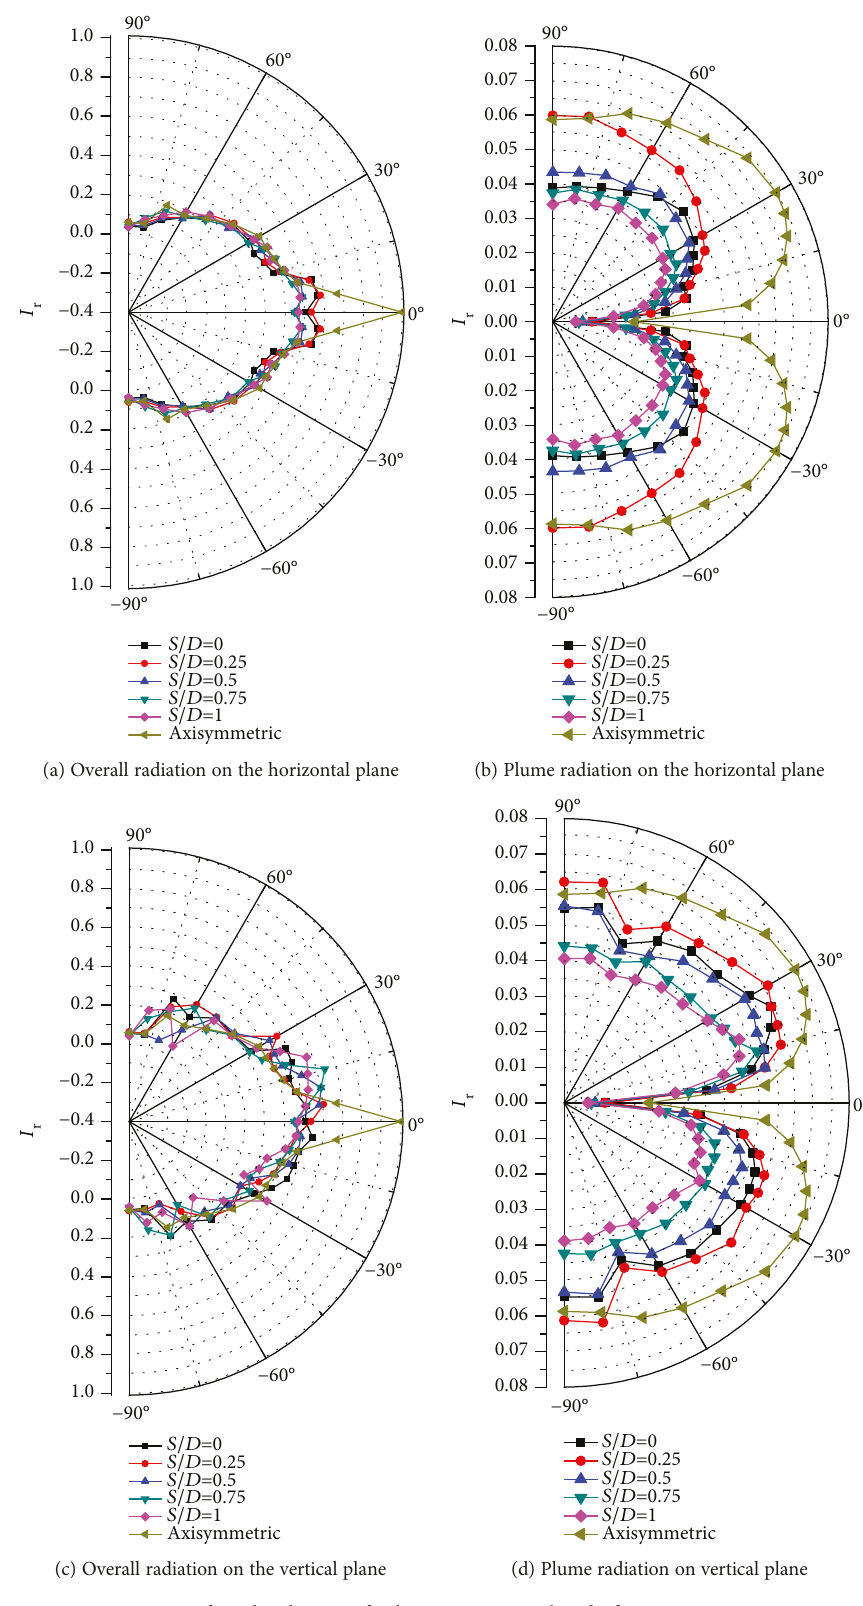
Figure 23: Infrared radiation of exhaust systems in band of 3-5 μ m varying S / D